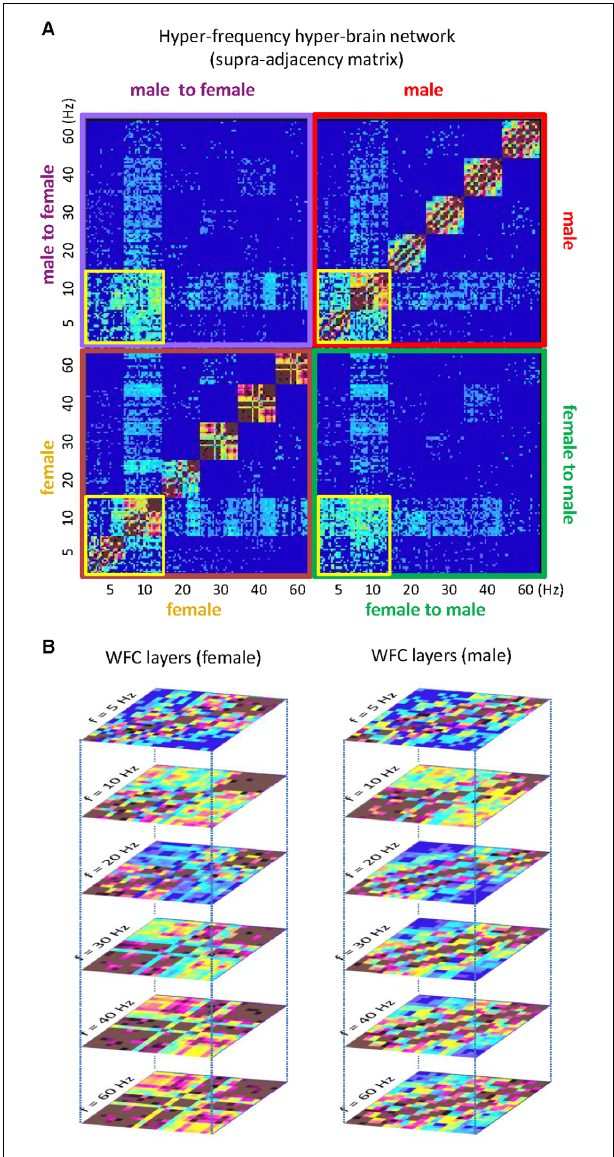
FIGURE 8 | Hyper-frequency hyper-brain network during kissing. (A) Supra-adjacency matrix of the common network. The supra-adjacency matrix (252 × 252) comprises all connections between 21 electrodes and six frequencies (5, 10, 20, 30, 40, and 60 Hz) within (brown and red quadrats) and between (green and purple quadrats) female and male brains, respectively. WFC connections between all electrodes within the female and male brains are distributed along the main diagonal of the matrix. The electrodes for each frequency are organized in anterior-posterior order from left to right: Fp1, Fpz, Fp2, ... ,O1, Oz, and O2. WFC connections between the brains are distributed along diagonals within the green and purple quadrats. The 5- and 10-Hz nodes (indicated by four smaller yellow squares) represent the so-called theta-alpha subnetwork. The alpha frequency (10 Hz) has the most connections and serves a cleaving or pacemaker function in the common network. (B) WFC layers of the female and male subnetworks or aspects. The WFC subnetworks are presented here in the form of a six-layer structure that is depicted in A along the diagonal. The connections between the layers within the female and male brains are represented by remaining edges in brown or red quadrats in A. The two other quadrats in A (green and purple) represent connections (WFC and CFC) between the